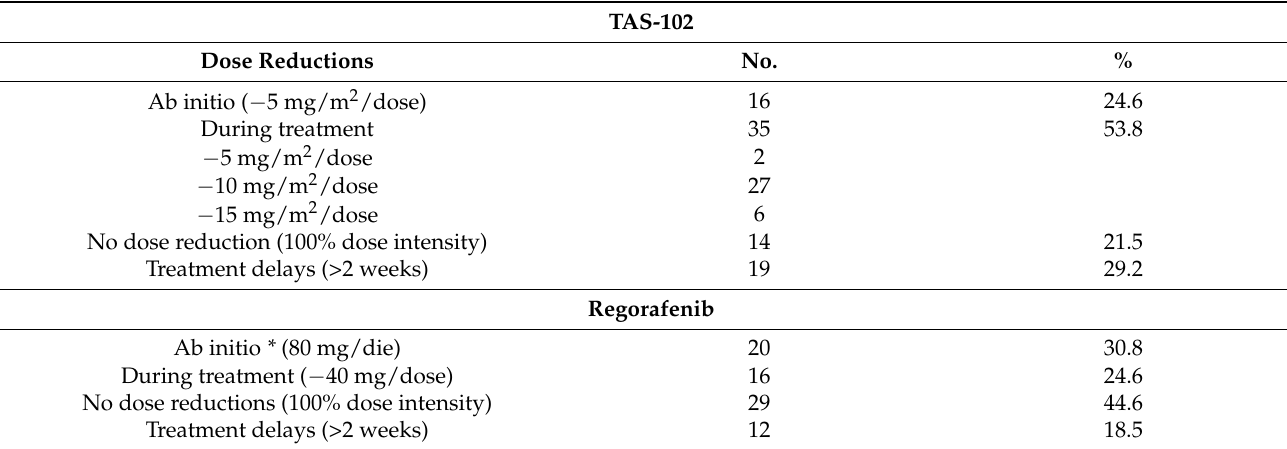
Table 3. Compliance to